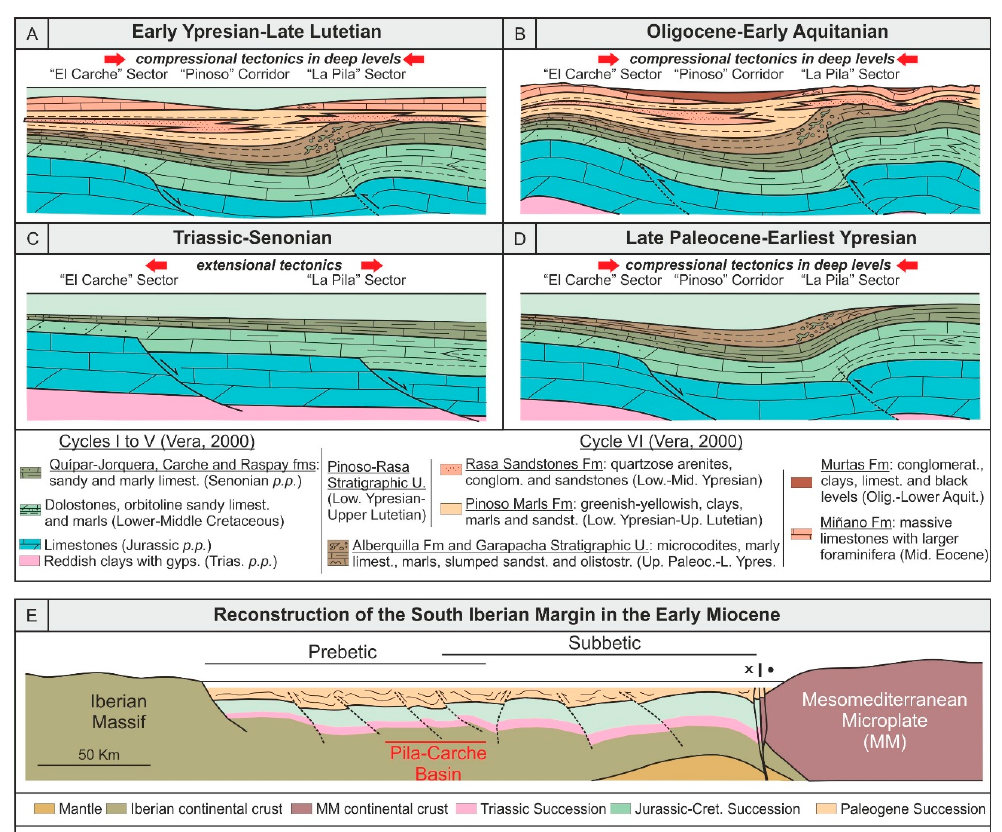
Figure 8. Paleogene tectono-sedimentary evolution of the Pila-Carche Cenozoic Basin (Murcia